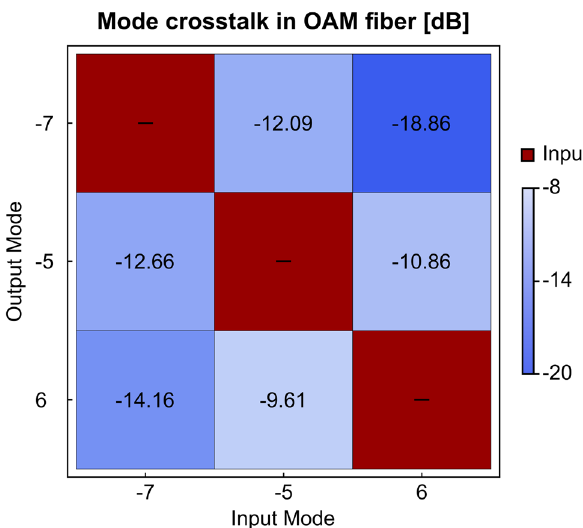
Figure 3: Mode crosstalk matrix in OAM fiber. On the x axis, we report the inputs mode ( − 7, − 5 and 6). On the y axis we report the output mode ( − 7, − 5 and 6). The measurement has been normalized per each mode.